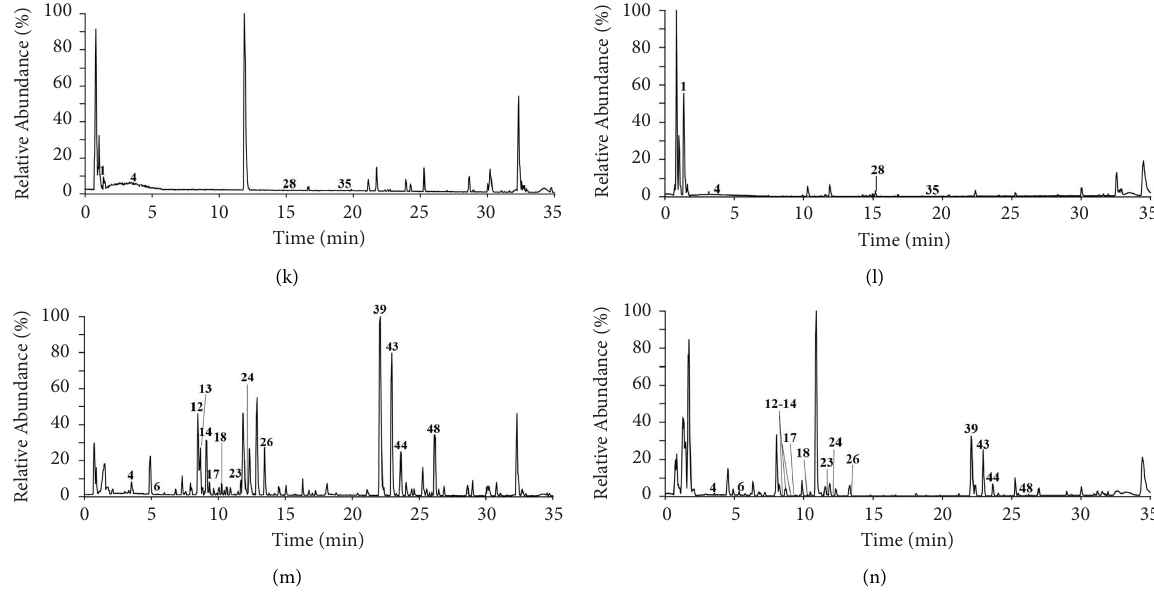
Figure 2: Total ion chromatograms of raw herbs from QZC. Duhuo extract in (a) positive ion mode and (b) negative ion mode, Xuduan extract in (c) positive ion mode and (d) negative ion mode, Hujisheng extract in (e) positive ion mode and (f) negative ion mode, Honghua extract in (g) positive ion mode and (h) negative ion mode, Laoguancao extract in (i) positive ion mode and (j) negative ion mode, Weilingxian extract in (k) positive ion mode and (l) negative ion mode, Zhicaowu extract in (m) positive ion mode and (n) negative ion